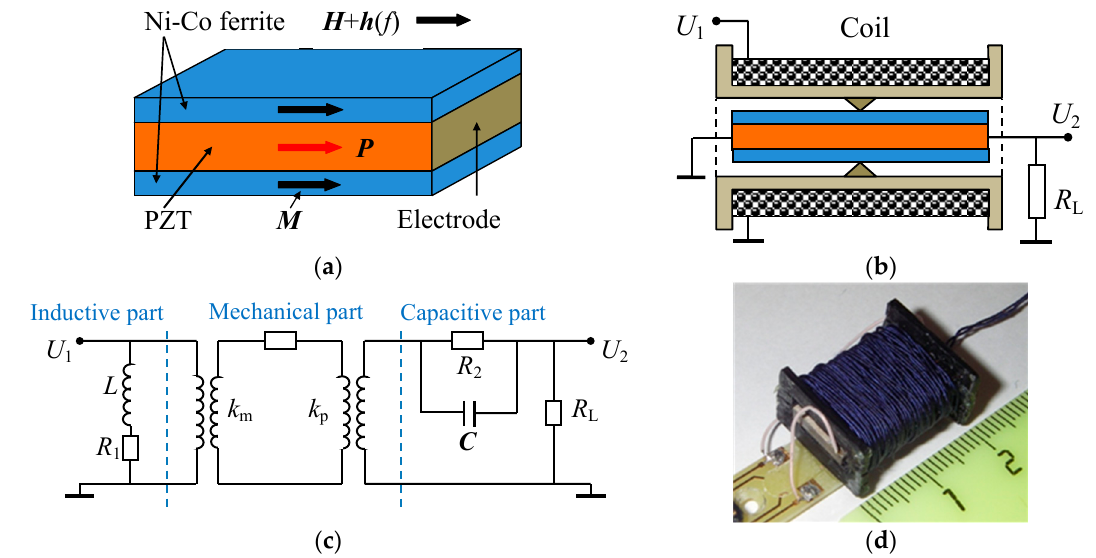
Figure 1. Schematic view of ( a ) the Ni-Co-ferrite-PZT heterostructure and ( b ) the transformer. The arrows denote directions of magnetic field H , magnetization M , and polarization P . ( c ) Simplified equivalent circuit of the transformer. ( d ) Picture of the ME transformer.